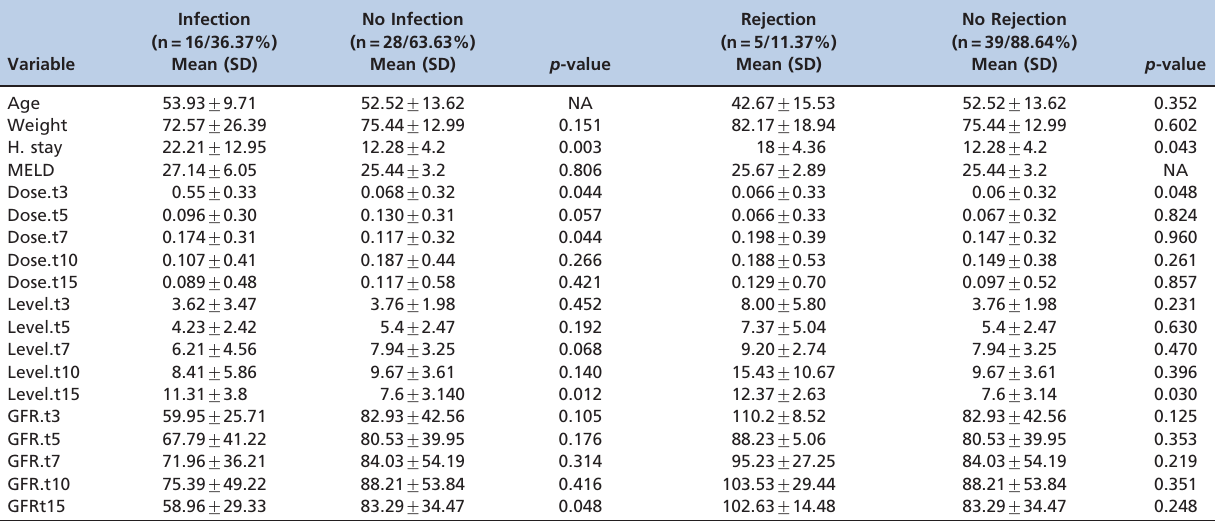
Table 2 - Comparison of the variables among the groups over time.